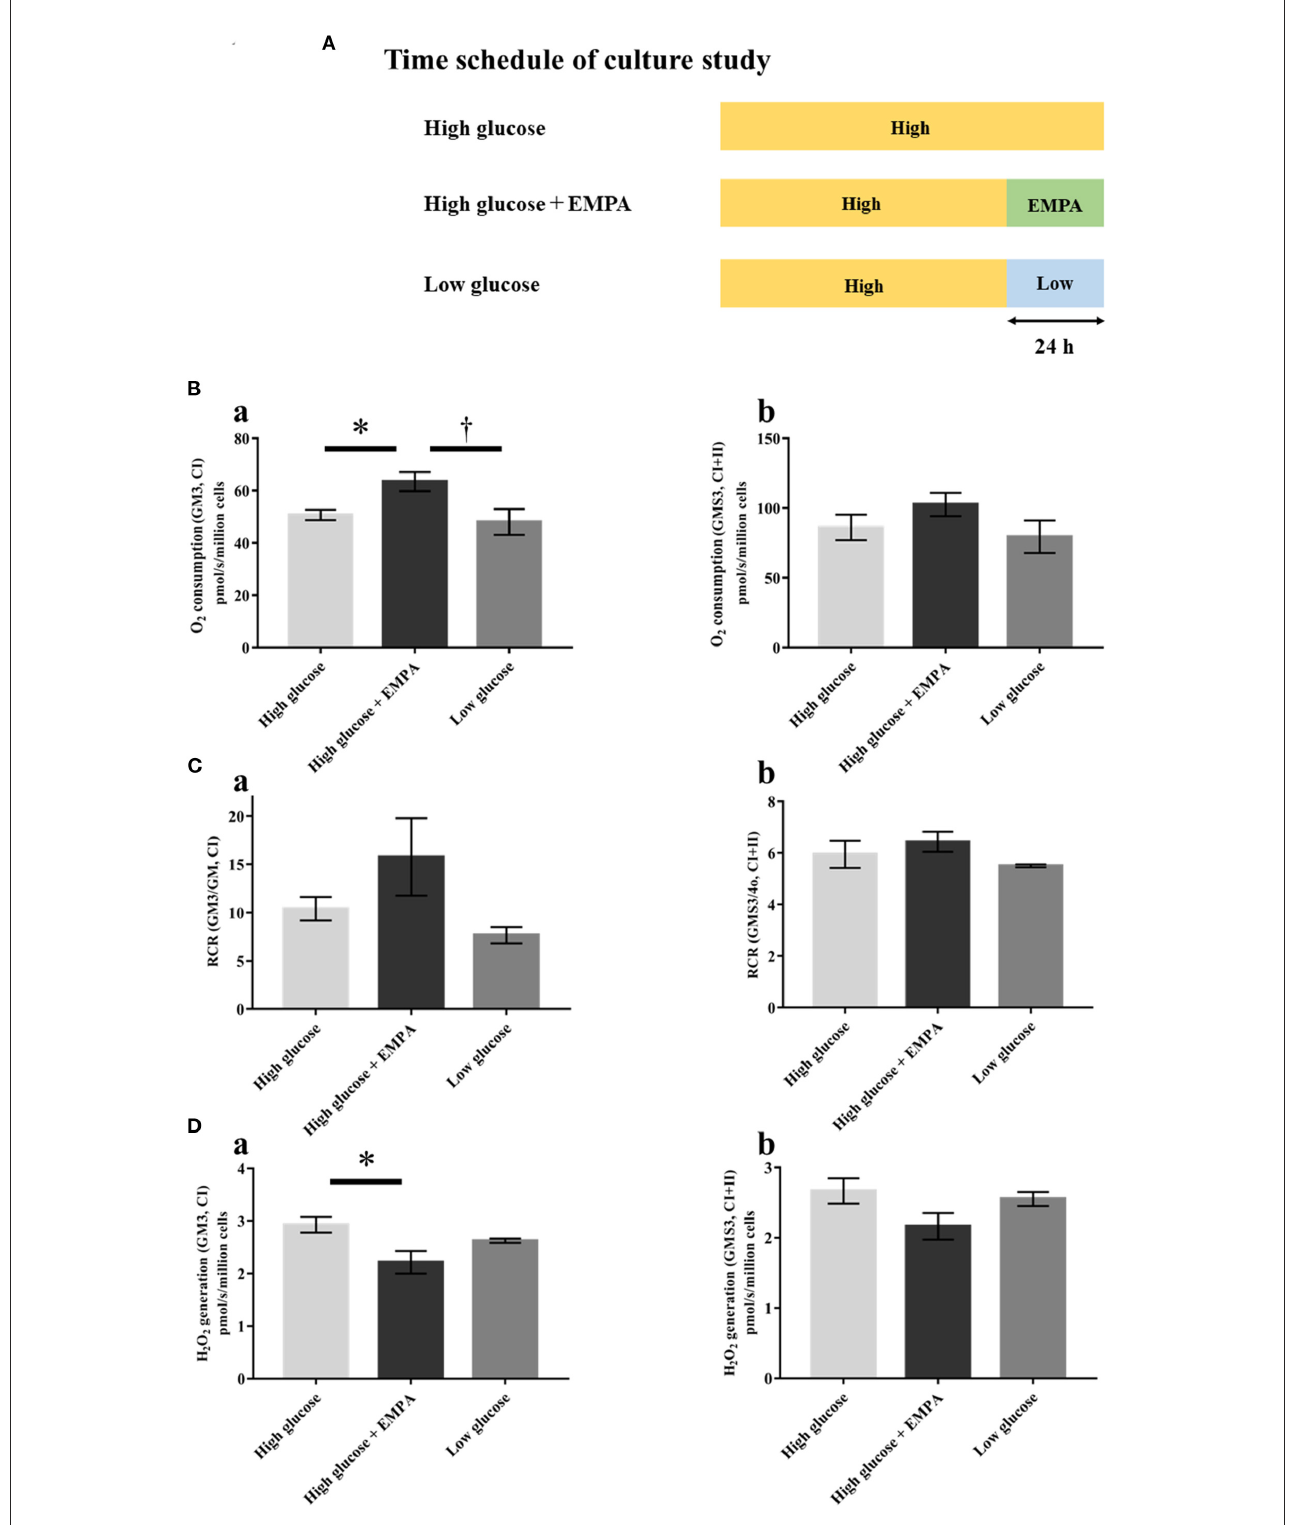
FIGURE7 Effects of empagliflozin on mitochondrial respiratory capacity and ROS generation in H9c2 cells. (A) Time schedule of culture study [High glucose (25 mmol/l); n = 4, High glucose + EMPA (10 µ mol/l); n = 3, Low glucose (2.5 mmol/l); n = 3]. (B) Mitochondrial H 2 O 2 generation with CI-linked substrates (a) and CI + II-linked substrates (b). (C) O 2 consumption with CI-linked substrates (a) and CI + II-linked substrates (b). (D) Respiratory control ratio (RCR) with CI-linked substrates (a) and CI + II-linked substrates (b). Data are expressed as mean ± SE. * p < 0.05: vs. High glucose, † p < 0.05: vs. High glucose + EMPA (One-way repeated ANOVA with post hoc Tukey’s multiple-comparison test. Abbreviations are as defined in Figure